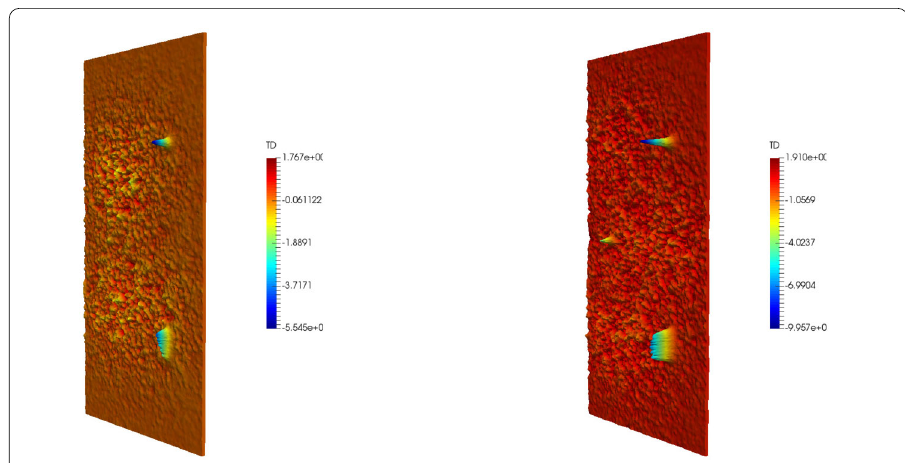
Figure 14 Topological derivatives shown in Figure 13 plotted as surfaces. Left: topological derivative corresponding to six linearly spaced frequencies between 0.2 and 2 Hz and a 2-by-2 grid of lamps. Right: counterpart when a 3-by-3 grid of lamps is used. True defects appear as coherent mountain-like structures opposite to the random peaks of the spurious minima